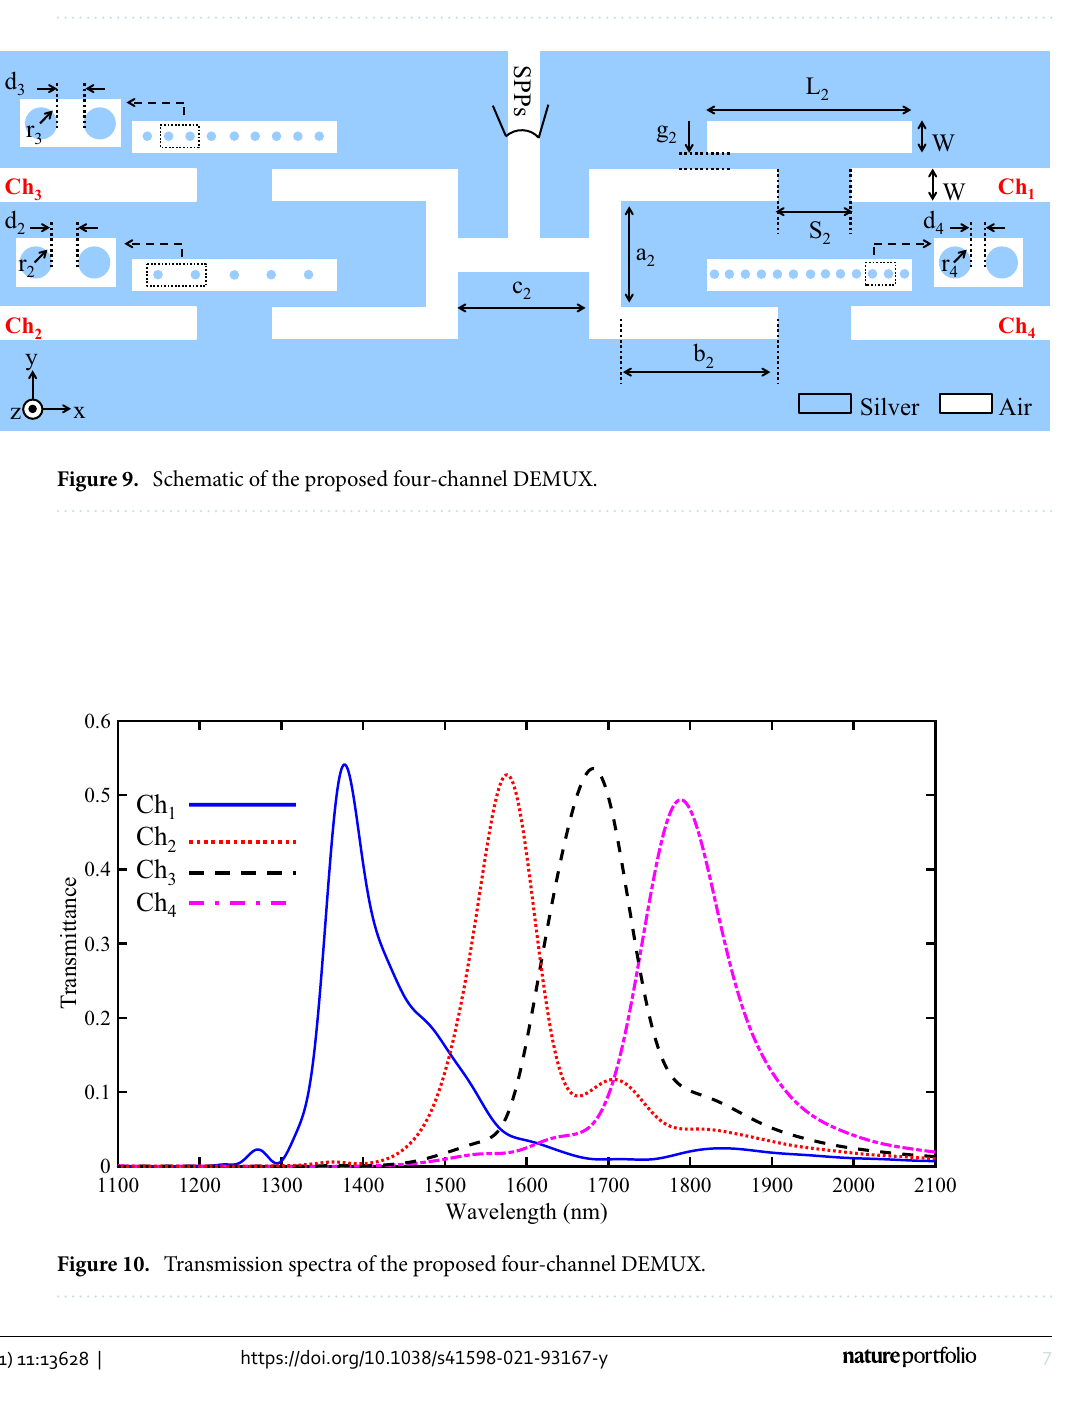
Figure 8. Field profile of | H z | for 1 × 2 DEMUX at the wavelength of (a) 1074 and (b) 1307 nm (Visual 1 and Visual 2).